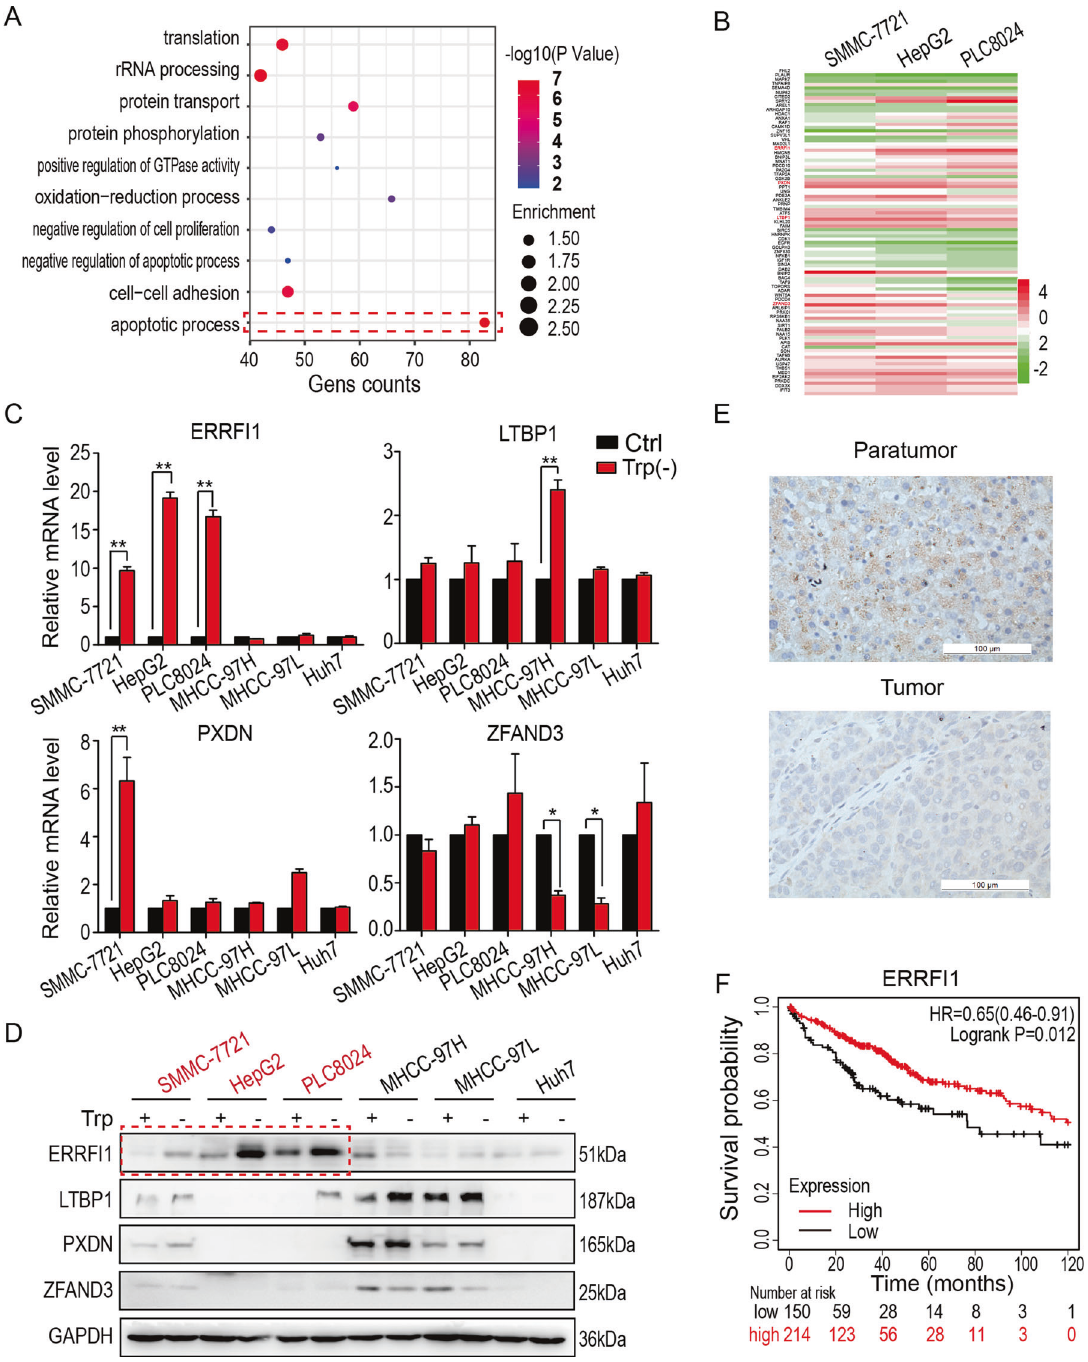
Fig. 2 The expression of ERRFI1 is positively correlated with prognosis in HCC. A Gene Ontology (GO) analysis on the commonly upregulated genes in three sensitive HCC cells (SMMC-7721, HepG2, and PLC8024) in response to tryptophan de fi ciency. B The mRNA expression heatmap of genes involved in apoptosis signaling in response to tryptophan de fi ciency. C , D . Expression detection of candidate genes including ERRFI1, LTBP1, PXDN, and ZFAND3 by qPCR and western blot in HCC cells with or without tryptophan supplementation. ** P < 0.01; * P < 0.05. E Immunohistochemistry analysis of ERRFI1 on clinical HCC samples. The paratumor tissue was considered as a control. Scale bar = 100 µm. F Kaplan – Meier analysis on ERRFI1 expression with overall survival of HCC patients.